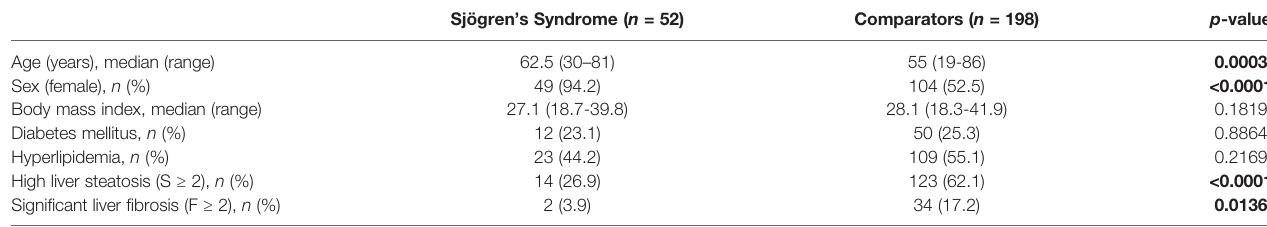
Bold p-values indicating statistically signi fi cant